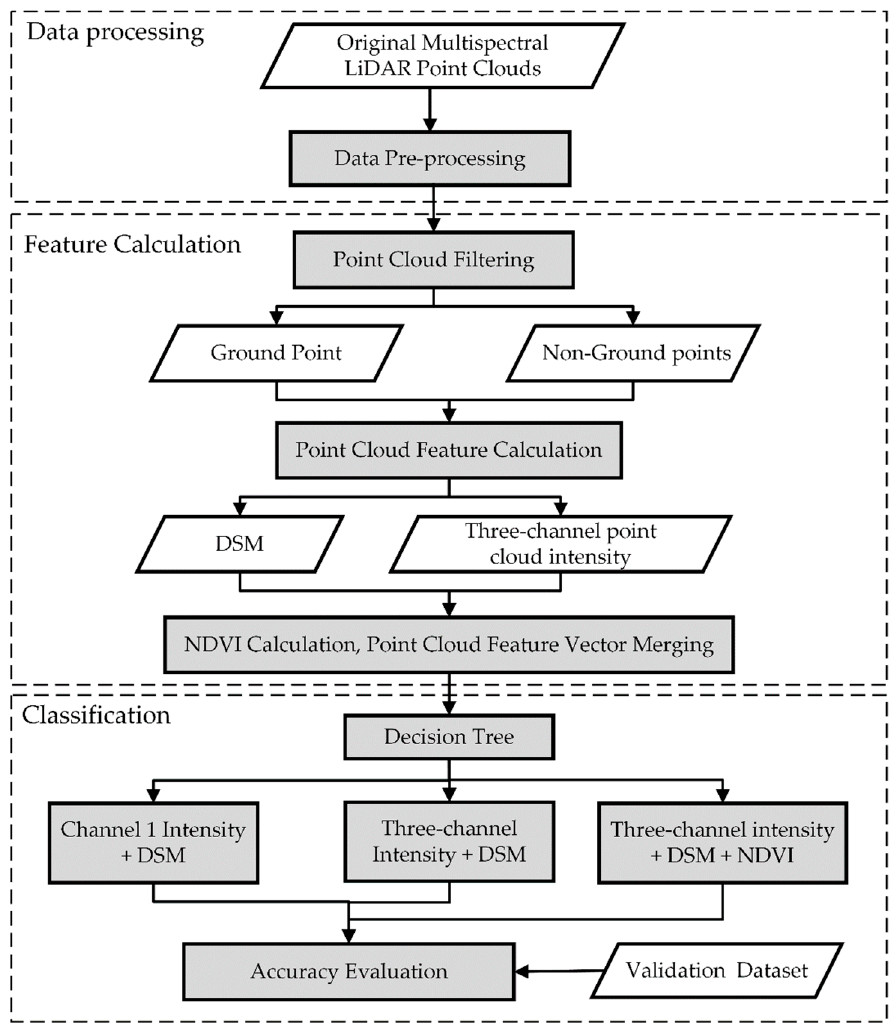
Figure 3. Flowchart of classification.